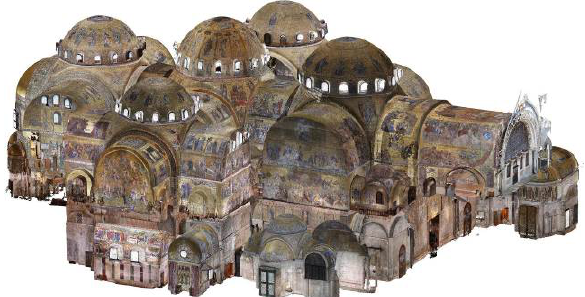
Figure 1: Union of all point clouds of the interior of the Basilica. The whole model is composed by 87 Photogrammetric point clouds and circa 9 billion of